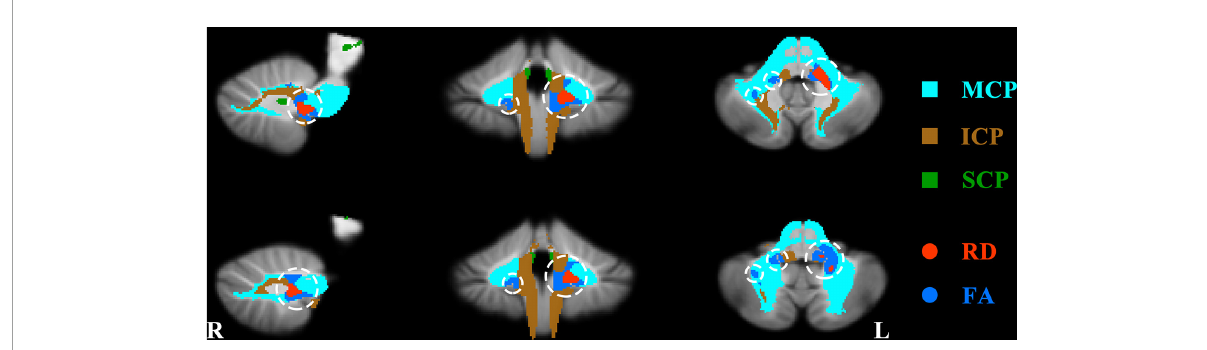
FIGURE1 Significant group difference about fractional anisotropy (FA) and radial diffusivity (RD) between patients and healthy controls. The regions of significant increased RD and decreased FA in the patients were shown with red and dark blue separately and circled with white circles. MCP, middle cerebellar peduncles; ICP, inferior cerebellar peduncles; SCP, superior cerebellar